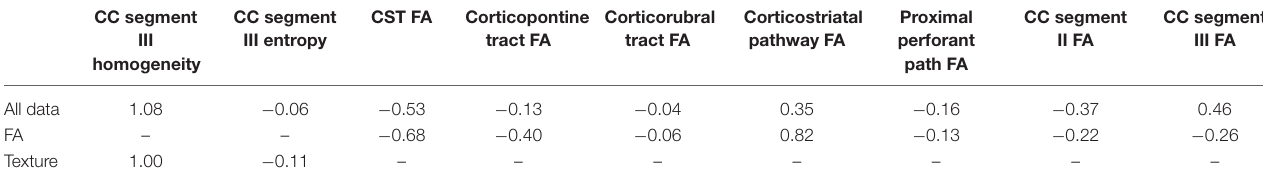
TABLE 3 | Linear coefficients of the support vector